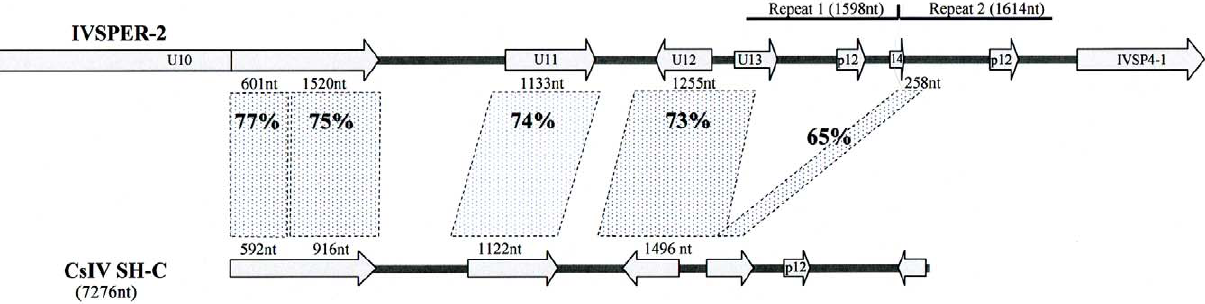
Figure 5. Schematic representation of the region in H.didymator IVSPER-2 displaying similarity to Campoletissonorensis IV segment SH-C (NCBI Reference: NC_007986.1). Five related sequences, showing more than 65% nucleotide identity, are highlighted. Arrows represent the predicted coding sequences in IVSPER-2 (names as per Figure 1) and CsIV SH-C (as determined using FGENESV0 at http://linux1.softberry.com/berry. phtml). The p12 genes are located in a less conserved region that has undergone duplication in IVSPER-2 (repeats 1 and